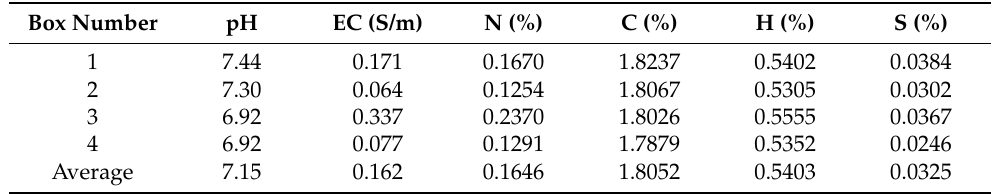
Table 7. Soil attributes after soil box percolation